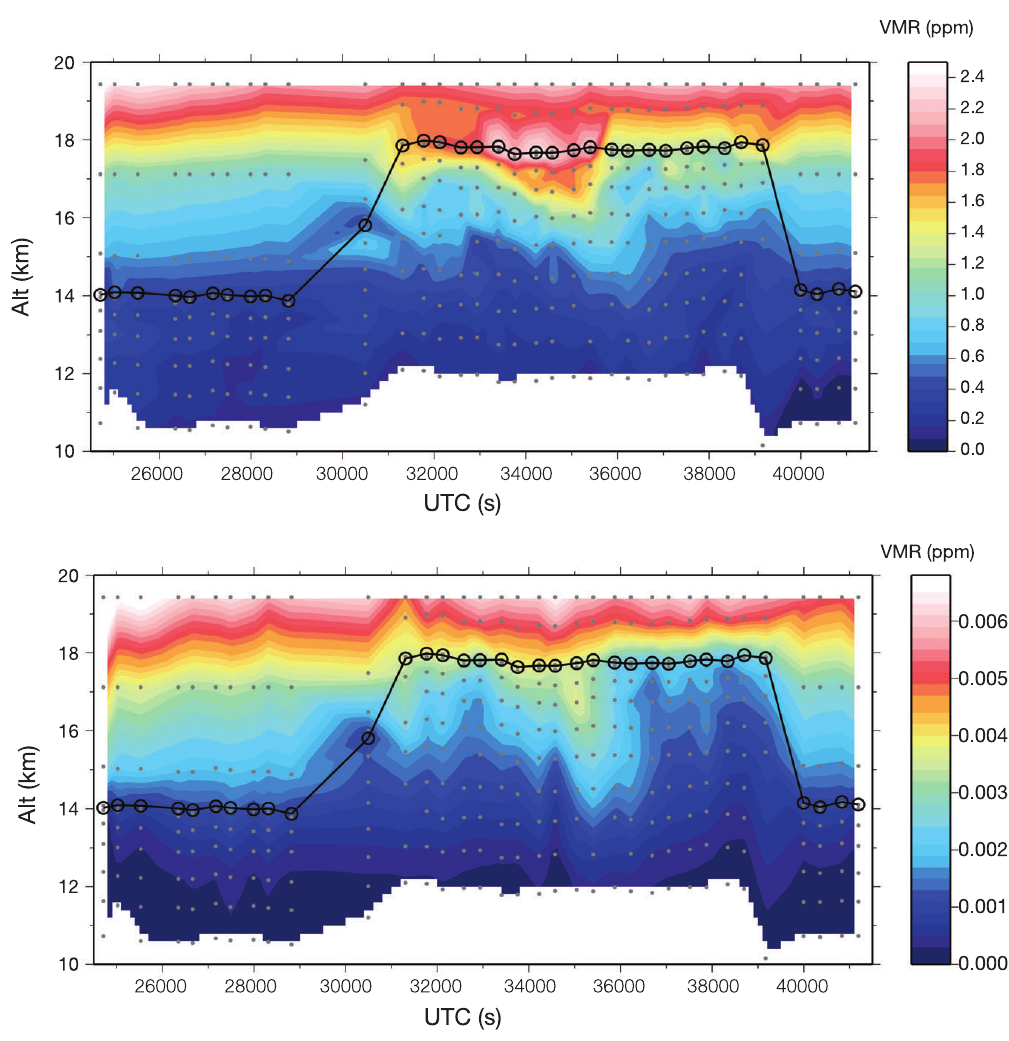
Fig. 17. Evidence of a vortex fi lament in simultaneous VMR maps of O observed during the APE-GAIA fl ight of 08.10.1999 near the Antarctic